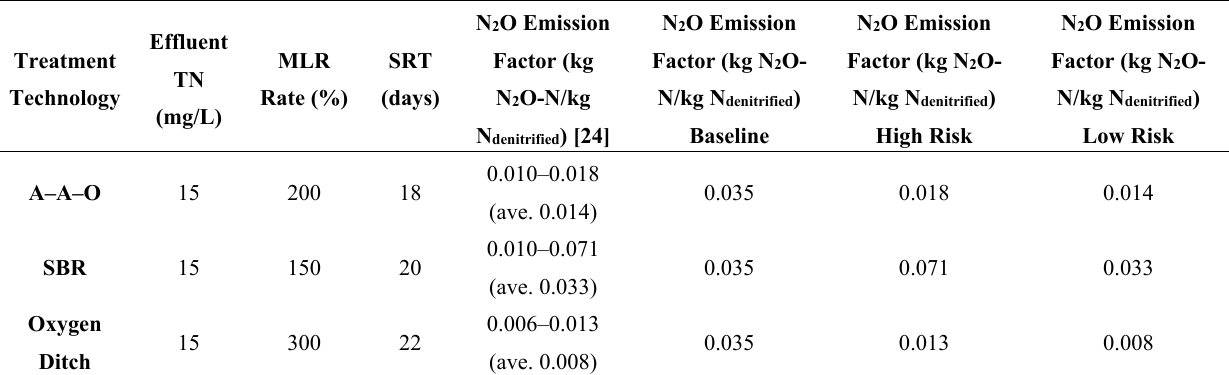
Table 4. Design parameters of three wastewater treatment alternatives and adjustment of N 2 O emission